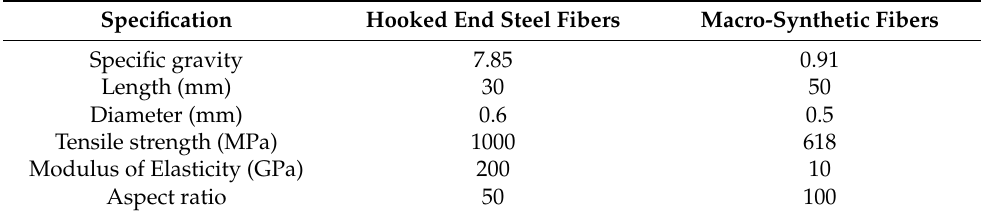
Figure 5. Details of fibers used: ( a ) macro-synthetic fibers, ( b ) hooked end steel fibers. Table 4. Mechanical properties of fibers . Table 4. Mechanical properties of fibers.